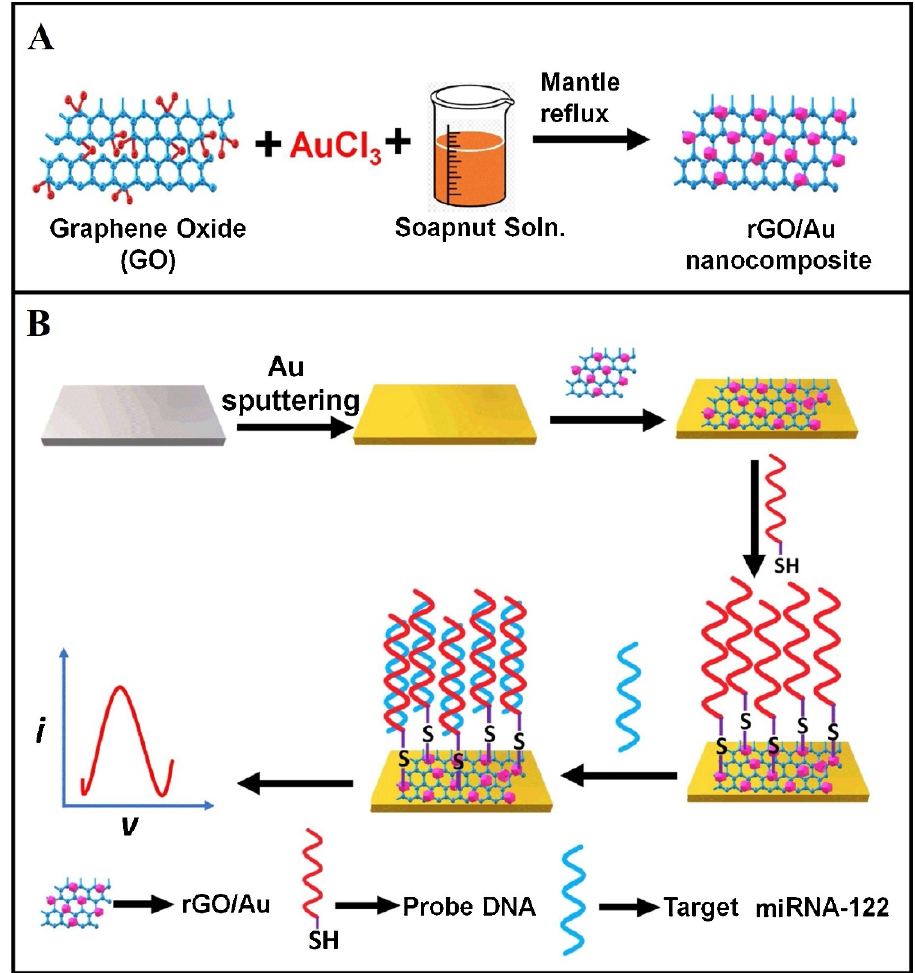
Figure 5. Schematic representation of the ( A ) Synthesis of rGO/Au nanocomposite, ( B ) Fabrication of rGO/Au nanocomposite-based miRNA-122 electrochemical detection platform. Reprinted with permission from Ref. [38] . Copyright 2021, Elsevier.